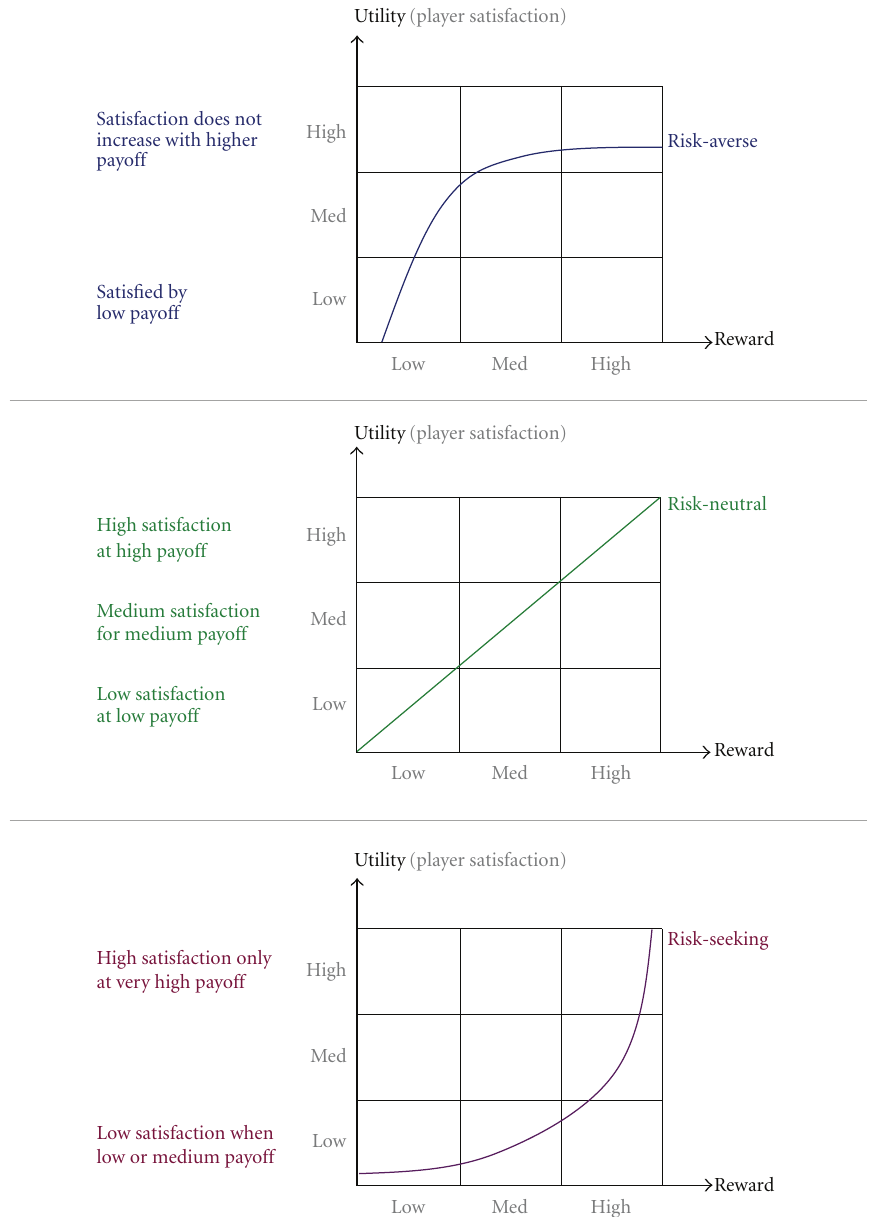
Figure 1: Three di ff erent risk profiles relating utility and reward. Note how risk seekers are only satisfied with large rewards accompanied by higher risks, while risk averse players prefer lower risk and reward